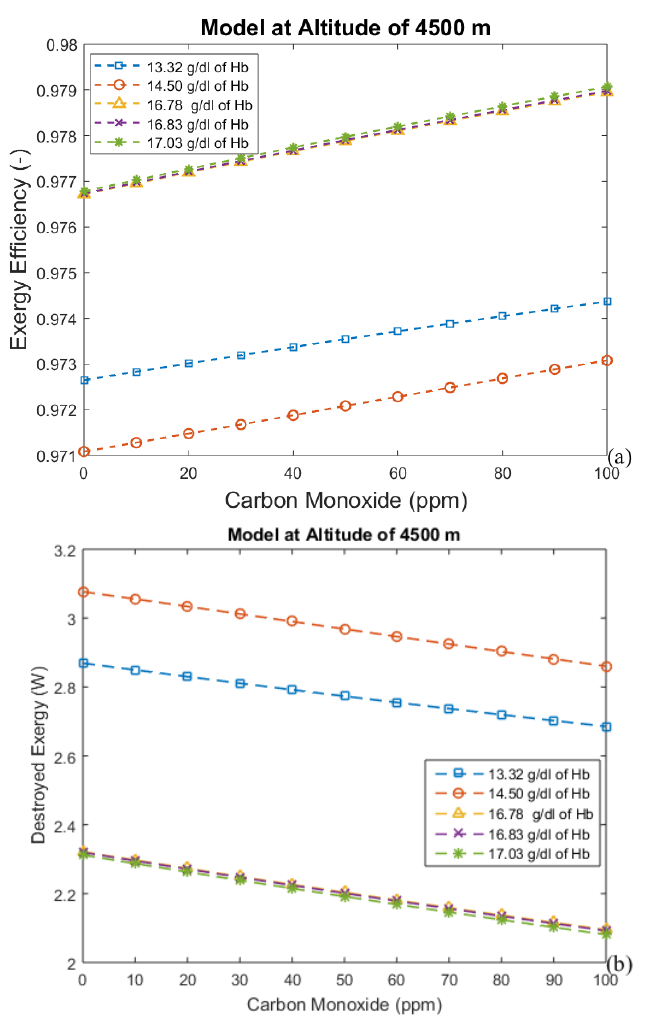
Figure 7. ( a ) Exergy efficiency and ( b ) destroyed exergy as functions of carbon monoxide and hemoglobin concentration at 4500 hemoglobin concentration at 4500 m.